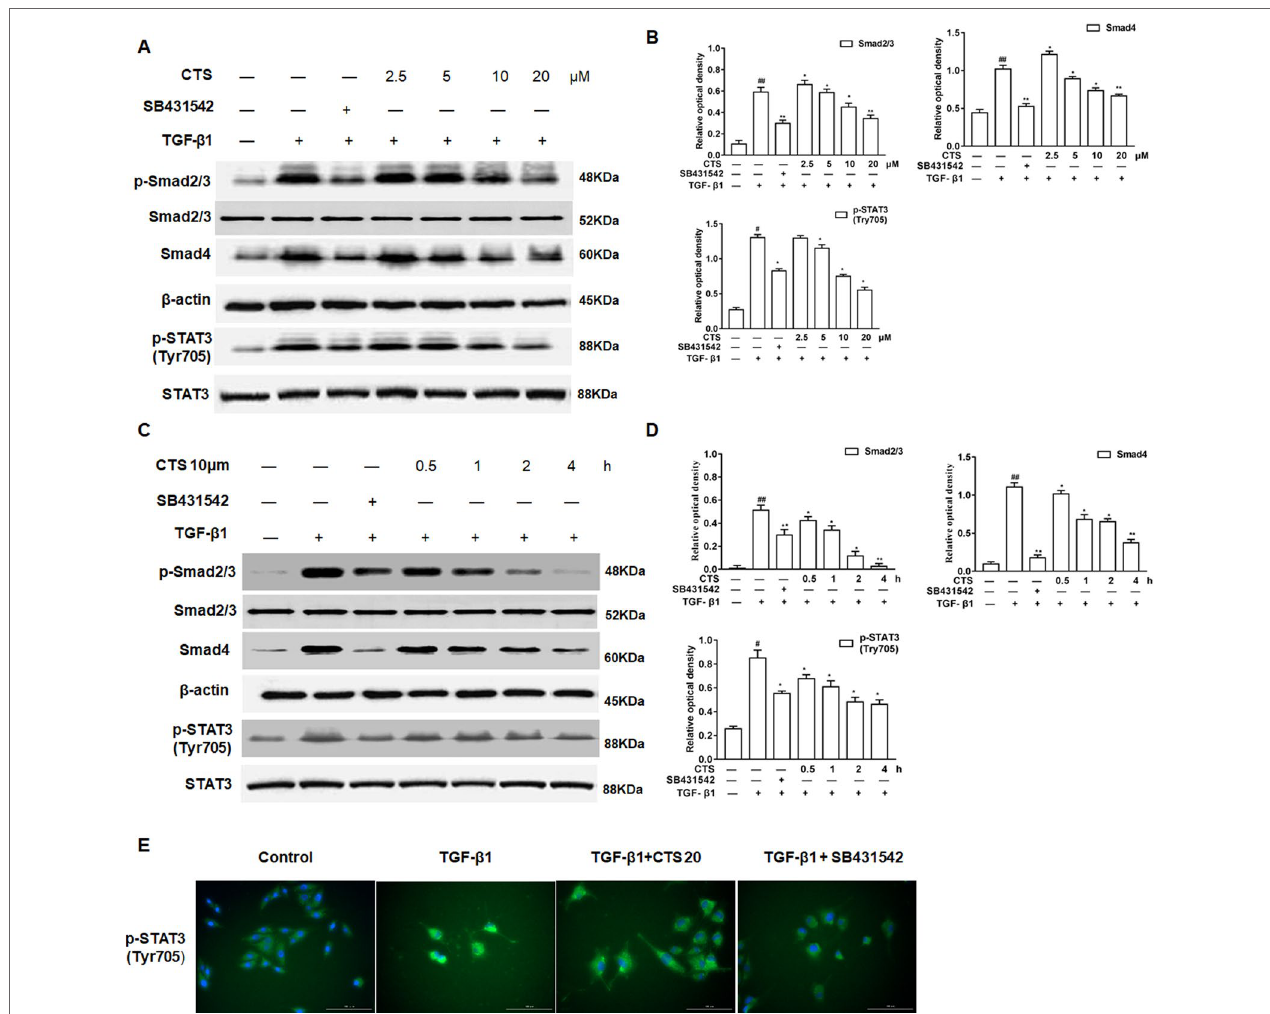
FIGURe 7 | The effect of cryptotanshinone (CTS) on the airway remodeling through transforming growth factor beta 1 (TGF-β1)/STAT3 in TGF-β1-induced airway smooth muscle cells (ASMCs). (A) Western blot of TGF-β1, p-Smad2/3, Smad4, p-STAT3 (Tyr705), and STAT3 in response to the treatment with SB431542 or different doses of CTS in ASMCs. (C) Western blot of TGF-β1, p-Smad2/3, Smad4, p-STAT3 (Tyr705), and STAT3 under the treatment with SB431542 or 10 μM CTS at different time in ASMCs. (B) and (D) Densitometric analysis was presented as the relative ratio of each molecule to Smad2/3, β-actin, and STAT3. Data were presented as mean ± SEM (n = 3). #P < 0.05, ##P < 0.01 vs. untreated group; *P <0.05, **P < 0.01 vs. TGF-β1-induced group. (e) The immunofluorescence analysis of p-STAT3 (Tyr705) in ASMCs showed that this protein was mainly expressed in the cytoplasm of ASMCs. Magnification: 200×. As shown in the pictures, p-STAT3 (Tyr705) was stained green and nuclei was stained with 4′,6-diamidino-2-phenylindole showing a blue color.